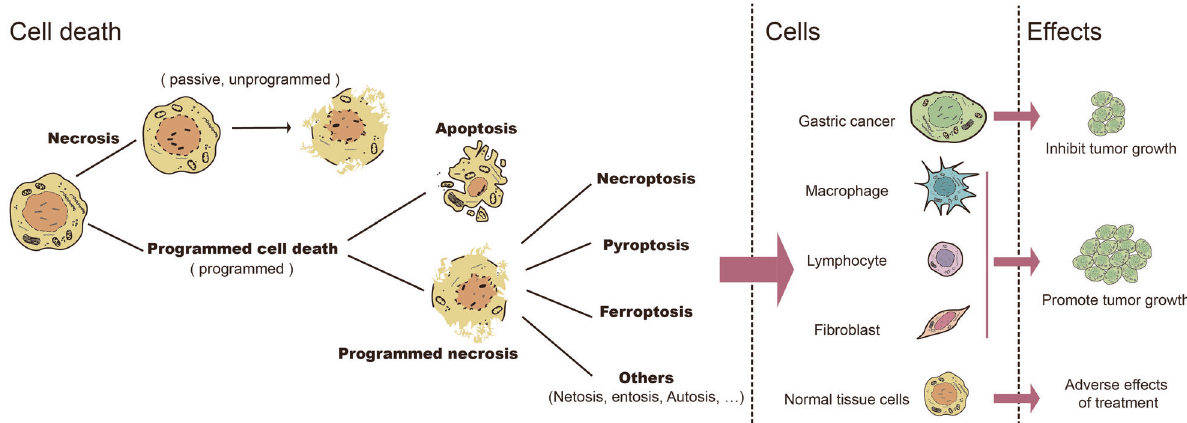
Fig. 1 The relationship between cell death and gastric cancer. Left: The classi fi cation of cell death. Middle: Cells that undergo death in gastric cancer. Right: Effects triggered by different cell death in gastric